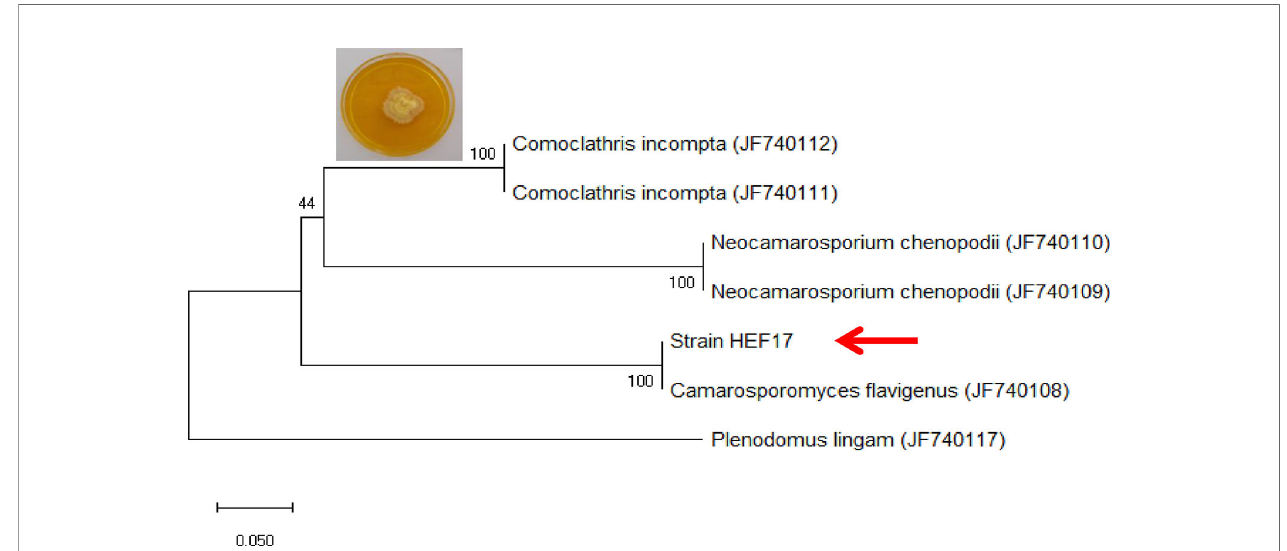
FIGURE 2 | Molecular identi fi cation of strain HEF 17 based on the analysis of the sequences of actin gene. The tree was rooted to Plenodomus lingam (CBS